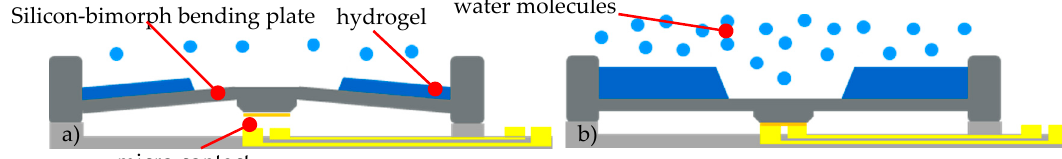
Figure 1. Basic operational principle of a humidity threshold sensor switch, consisting of a bimorph bending plate with patterned hydrogel layer and micro-contacts, ( a ) open and ( b ) closed (adapted from Reference [7]).